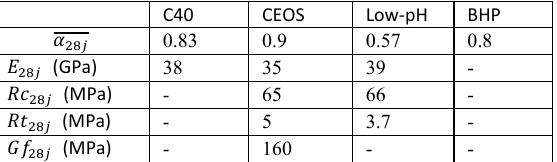
Table 3. Parameters of the macroscopic evolution law for the different mechanical characteristics.